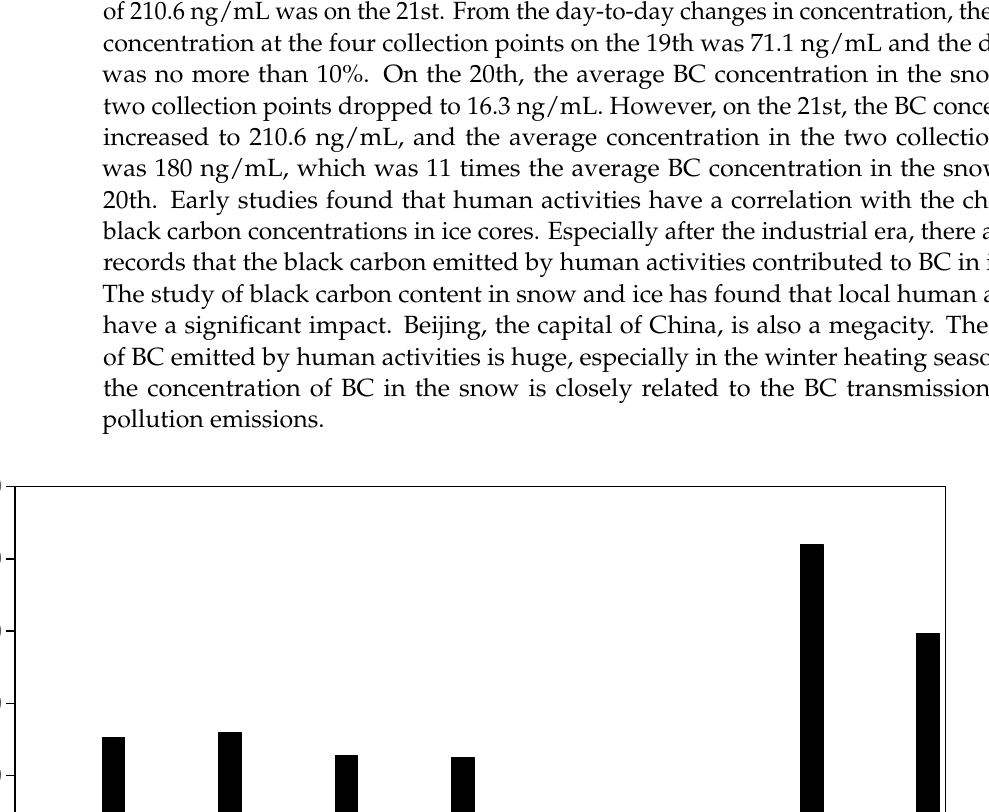
Figure 6. Size distribution of BC in snow. 3.3. Meteorological Effects on Day-to-Day Variation in BC Concentration in Snow In order to confirm the reason of sudden increase in BC concentration, we used the WRF weather background field and the closest (10 km away) wind profile radar from an observation station dating from 19–22 November 2015 (Figure 7). On the 19th, the Eura- sian middle-high latitude areas were two-slot and one-ridge. The Lake Baikal area was in the low vortex before the high-pressure ridge and in the wide transverse trough area, with the ground controlled by cold high pressure. In the western part of the mid-layer in the